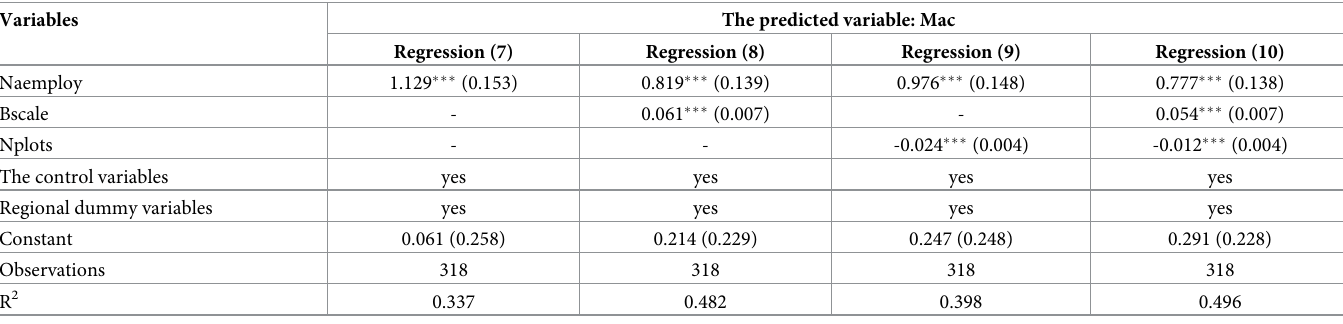
Table 4. Model estimation results of mechanical use behavior of sample